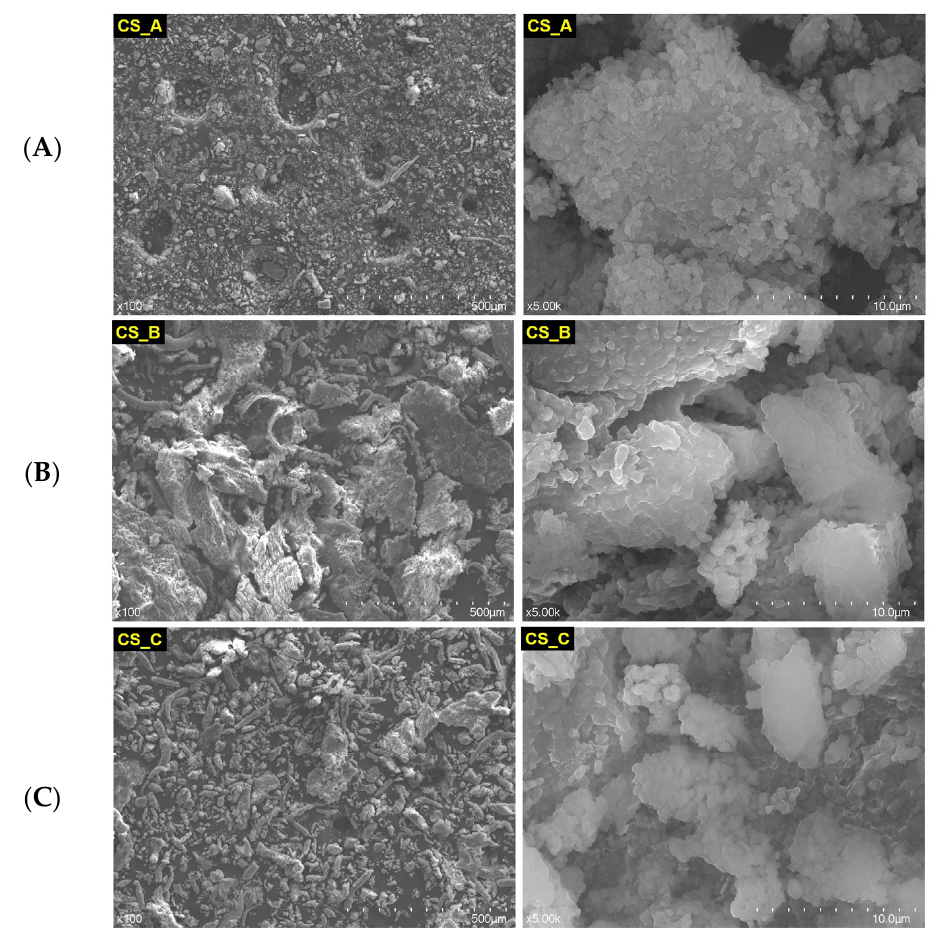
Figure 2. SEM images of CS restorative material powder, nonexposed ( A ) and exposed (rough ( B ) and fine ( C )) to acidic artificial saliva.